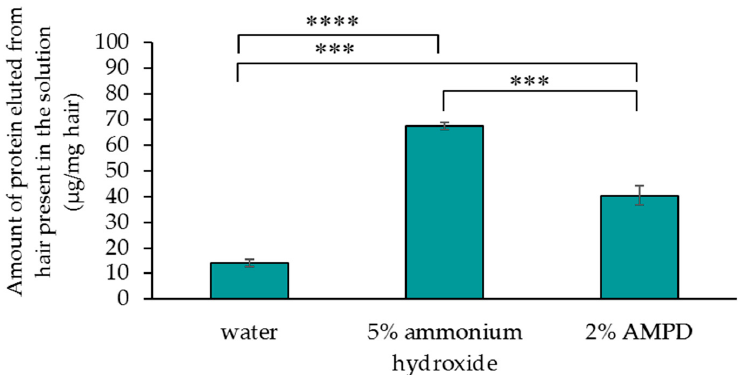
Figure 5. Determination of quantities of protein lost from human hair after using 5% ammonium